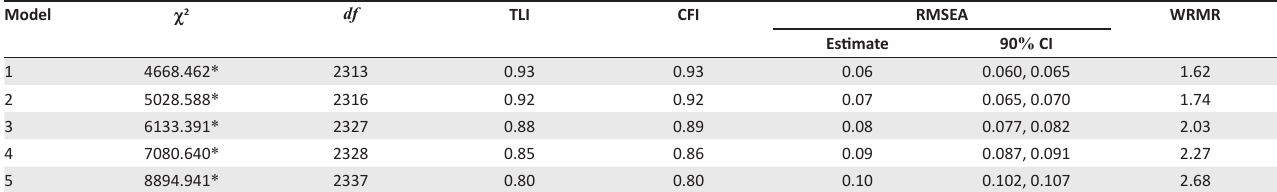
TABLE 2: Goodness-of-fit statistics of competing measurement models.